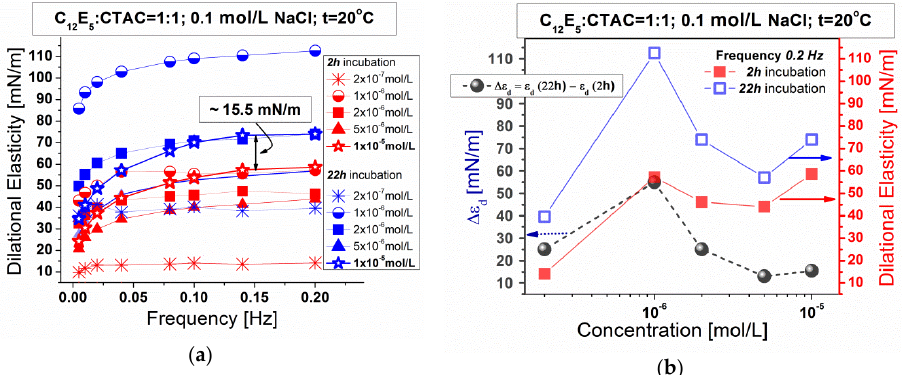
Figure 4. Evolution of dilatational elasticity values. ( a ) Frequency dependence of dilatational elasticity at two different ageing times of the adsorption layers—after 2 h (red symbols) and 22 h (blue symbols) from the beginning of the formation of the fresh surface. ( b ) Dilatational elasticity for 0.2 Hz frequency as a function of surfactant concentration after 2 h (red symbols) and 22 h (blue symbols).